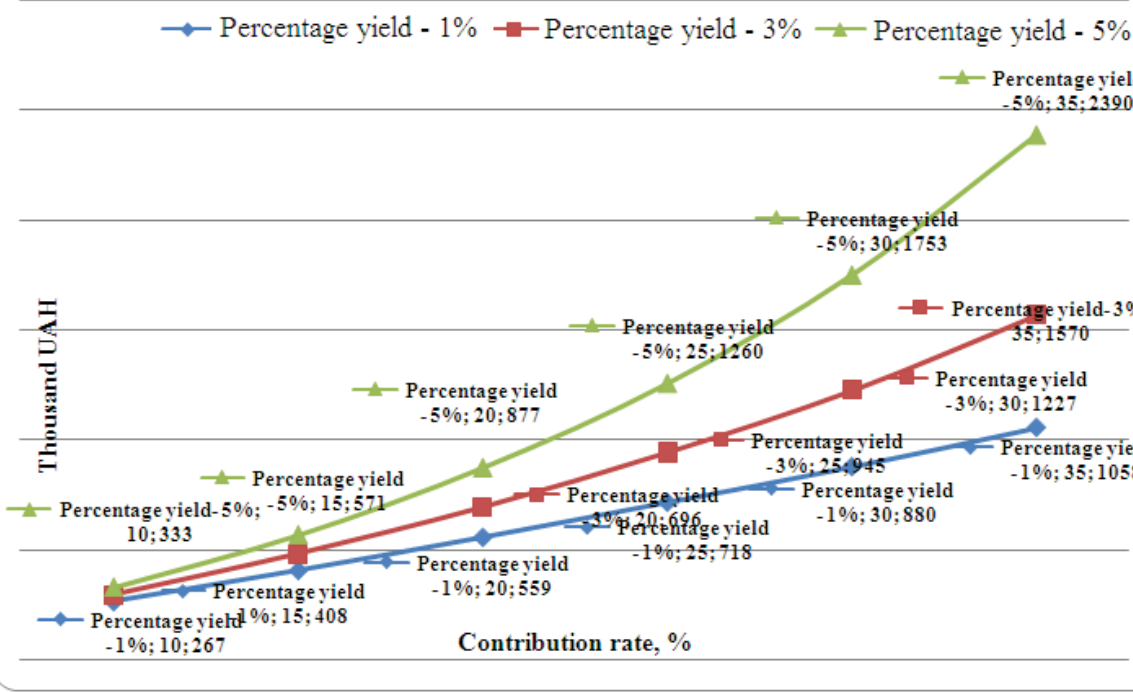
Fig. 2. Dependence of the volumes of accumulation of funds on the percentage